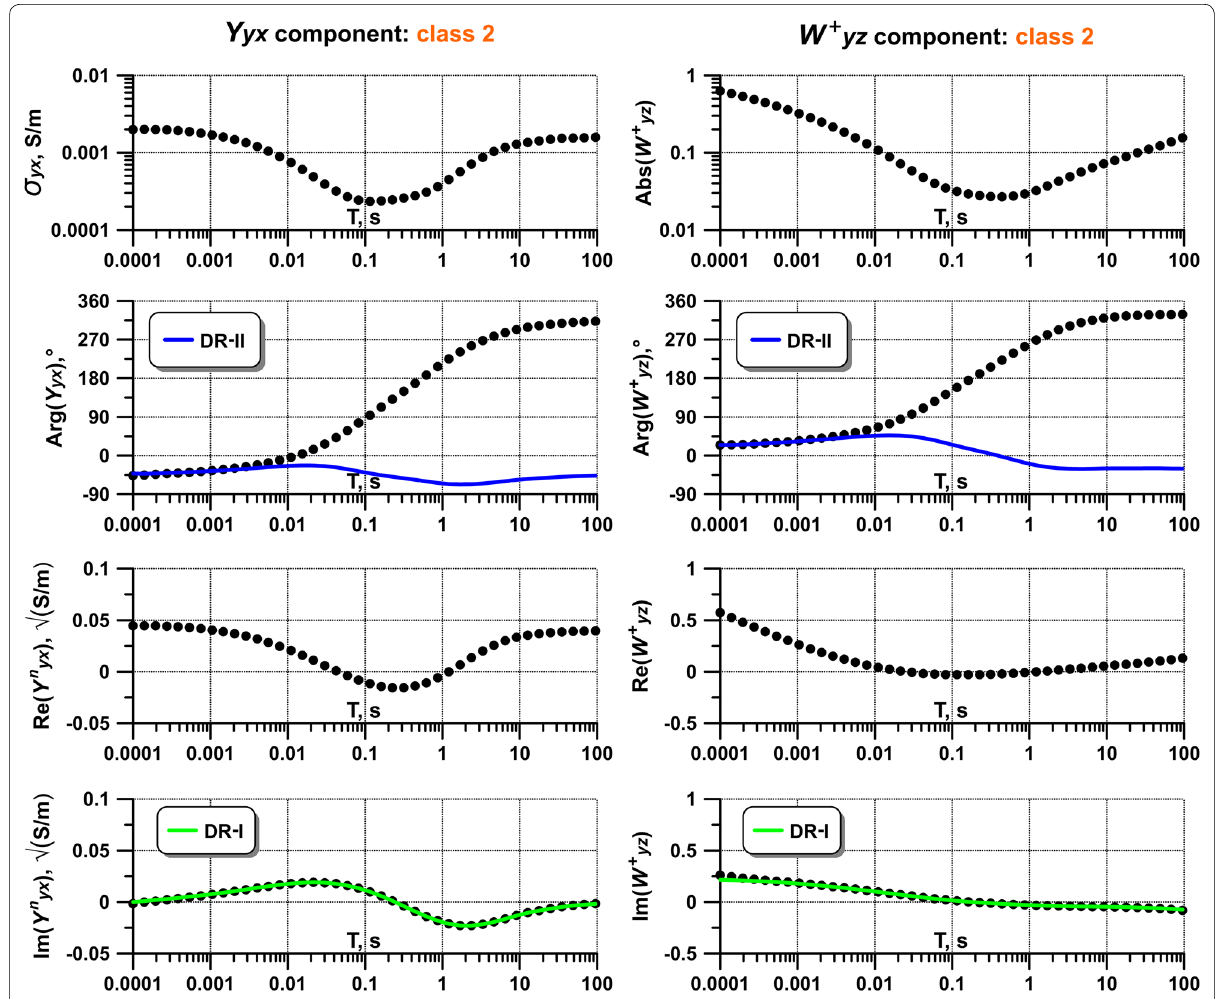
Fig. 6 The DR validity in Y yx and W + yz components observed near the 2-D